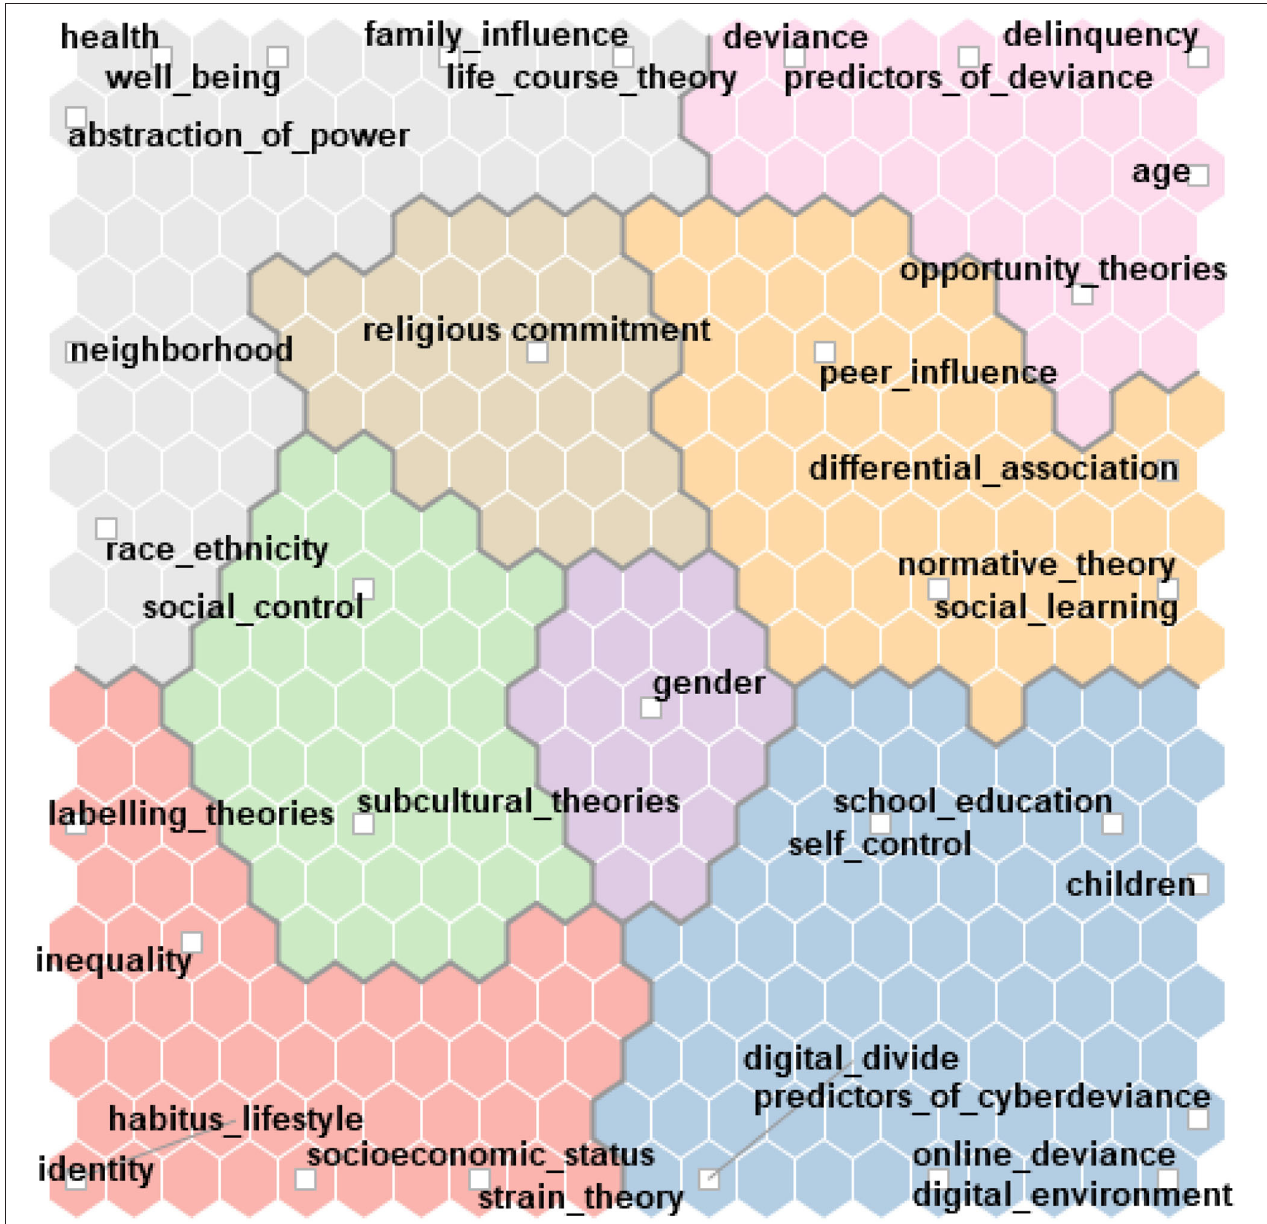
FIGURE 4 | The coding schema.